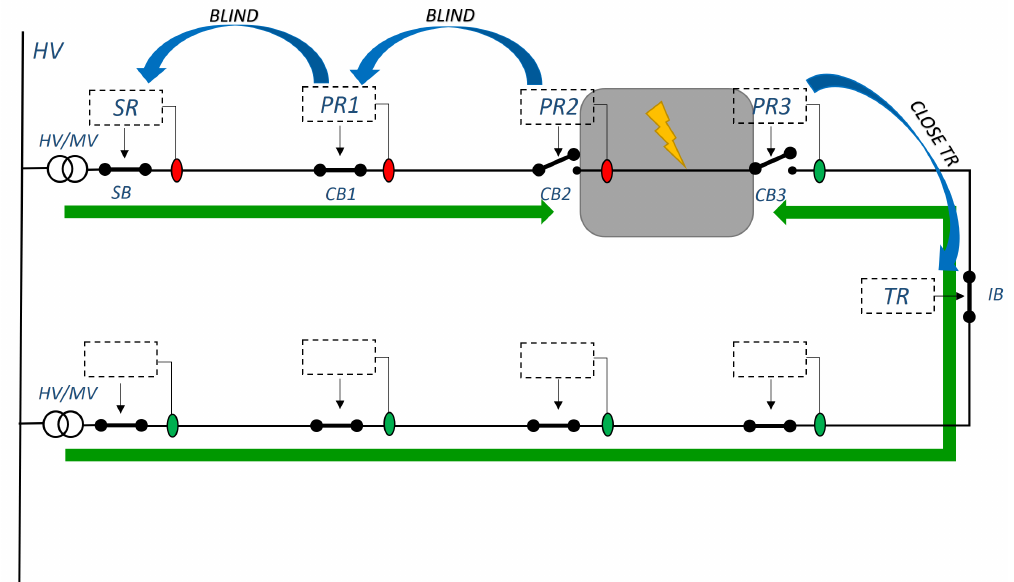
Figure 12. Message exchange between protections during the fault 50.S3 between PR2 and